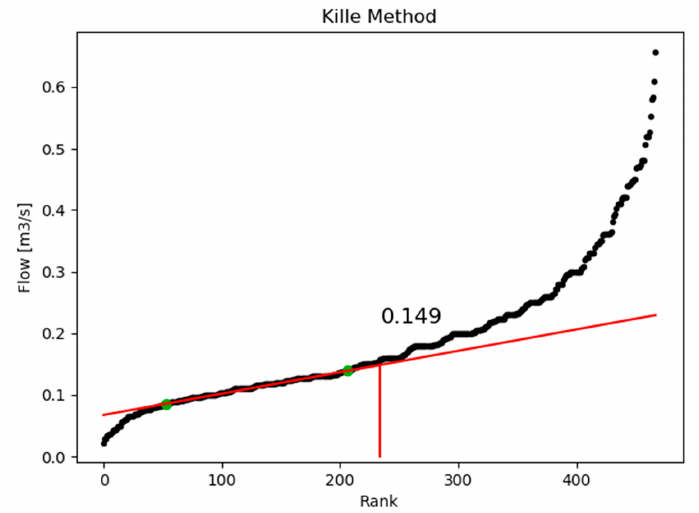
Figure 5. Ranked monthly flow minima according to Kille [43] and mean baseflow value. The green dots are the manually selected interpolation points for the fitted red line. Based on daily flow data from the HLNUG [32].